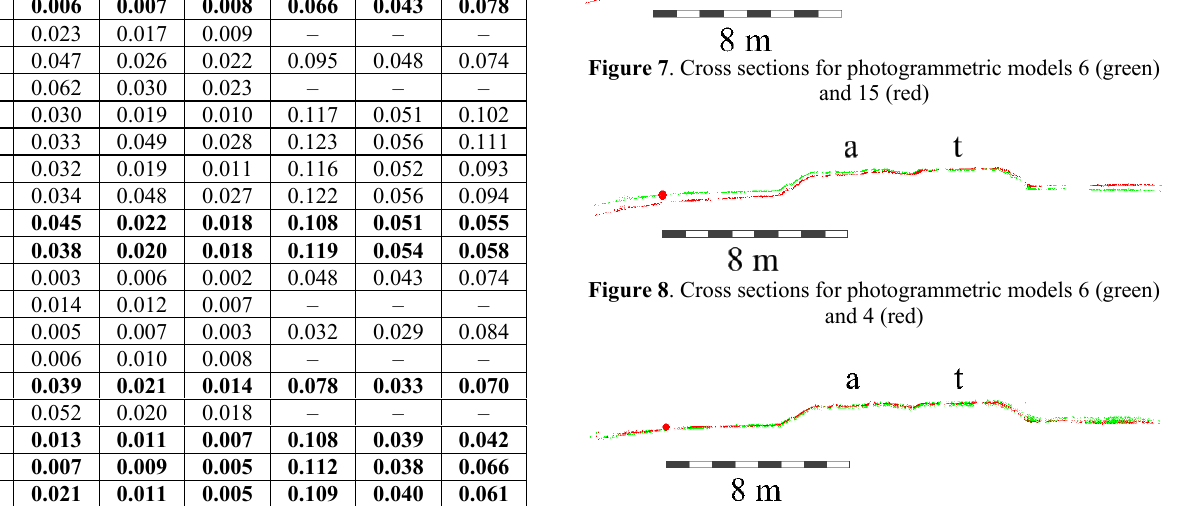
Figure 9. Cross sections for photogrammetric models 6